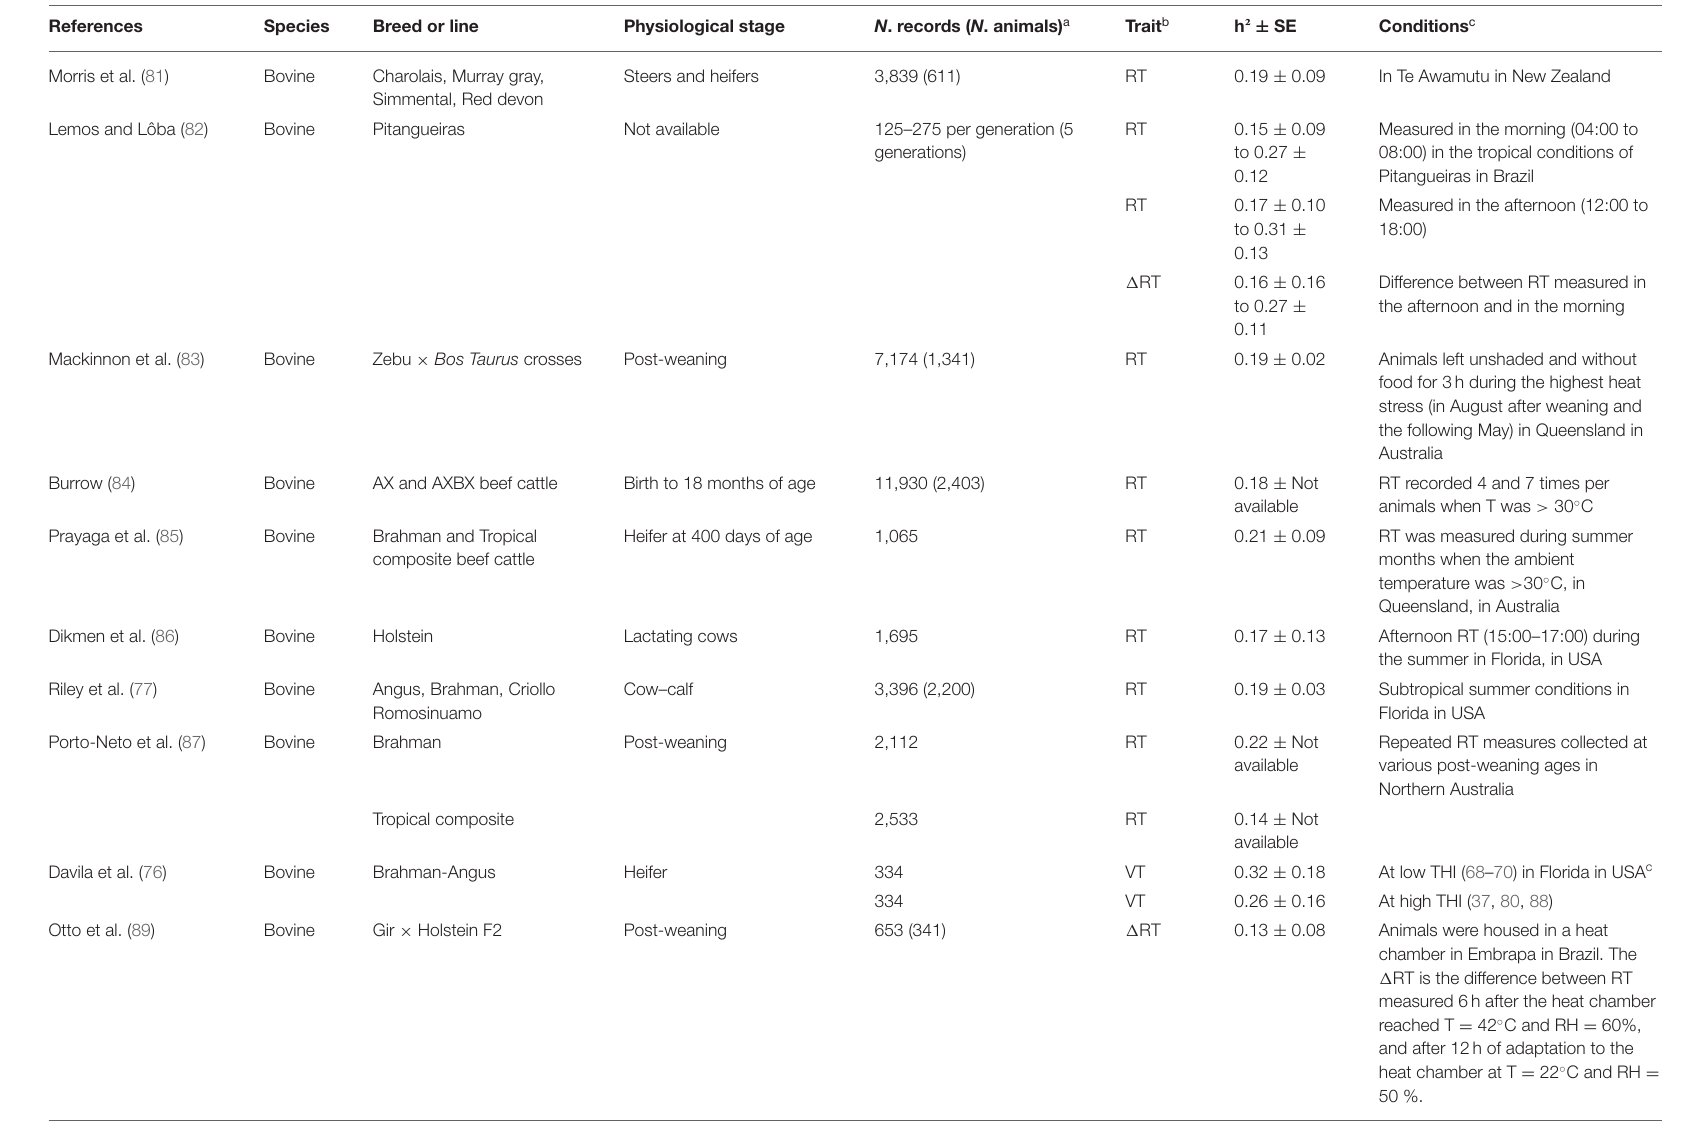
TABLE 2 | Heritabilities (h ² ± SE) of body temperature and respiratory rate in different livestock